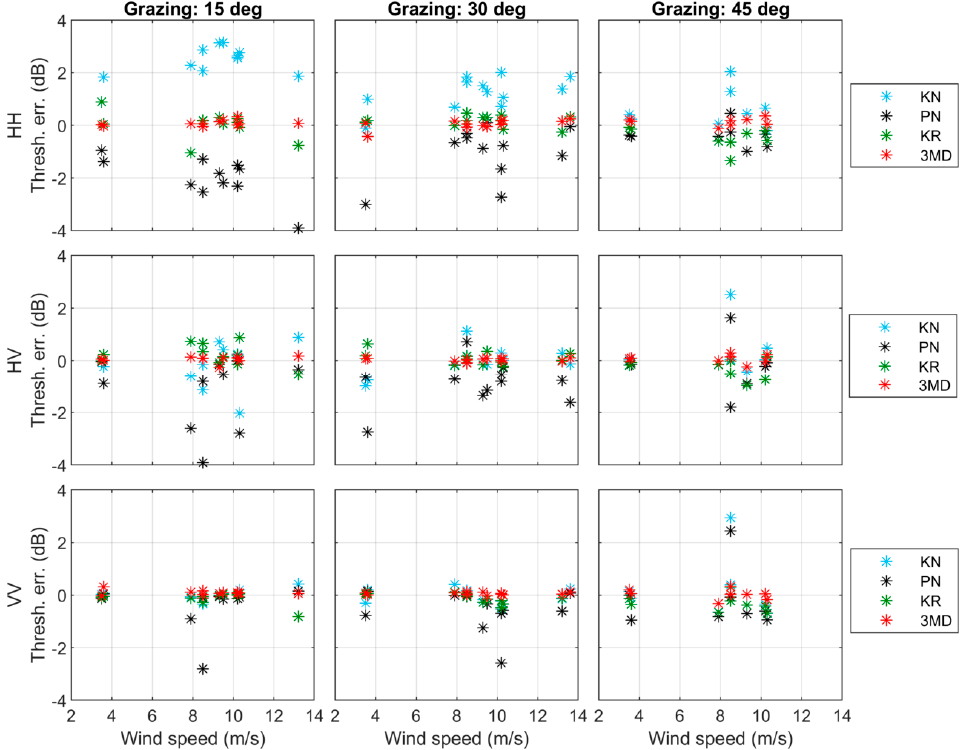
Figure 17. Threshold error against windspeed in the upwind direction for the INGARA dataset. Threshold error is measured at a CCDF of 10 − 4 .